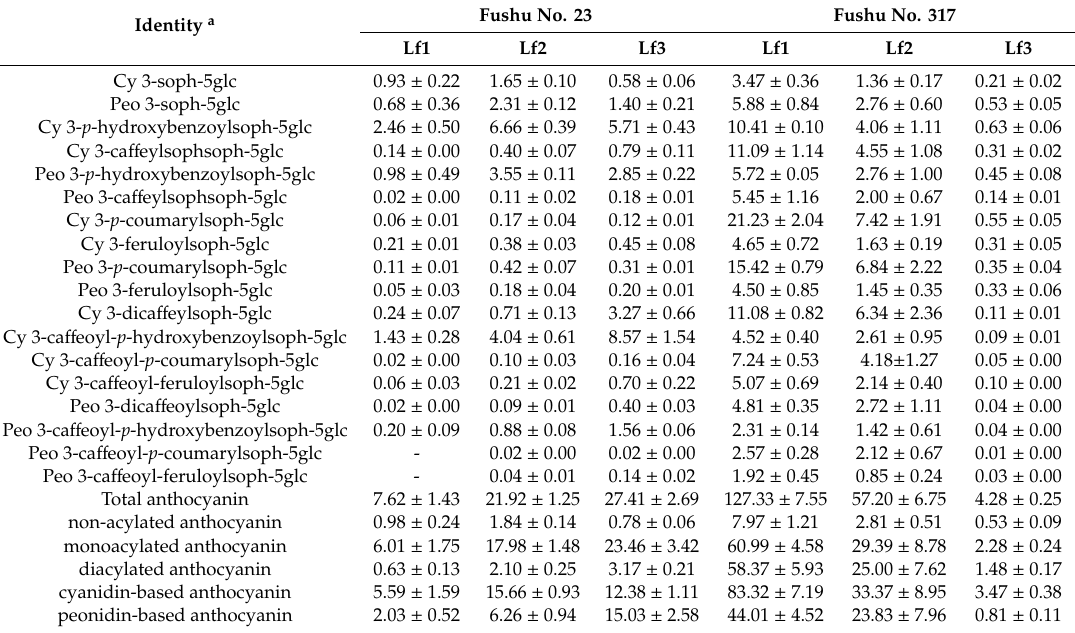
Table 2. Anthocyanin monomer (1–14) content in cultivar Fushu No. 23 and cultivar Fushu No. 317 as determined by ultra performance liquid chromatography ( µ g / g fresh weight,